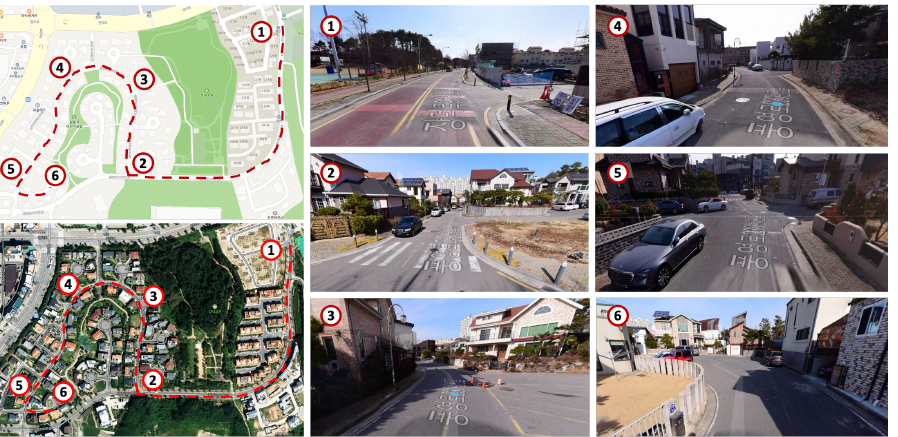
Figure 1. Specific routes in a residential